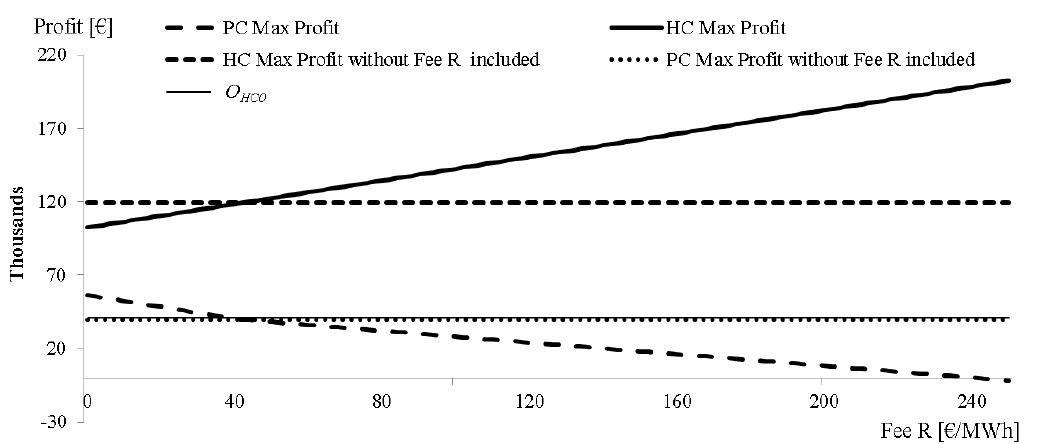
Figure 10. Fee R impacts on PC/HC profit in Scenario